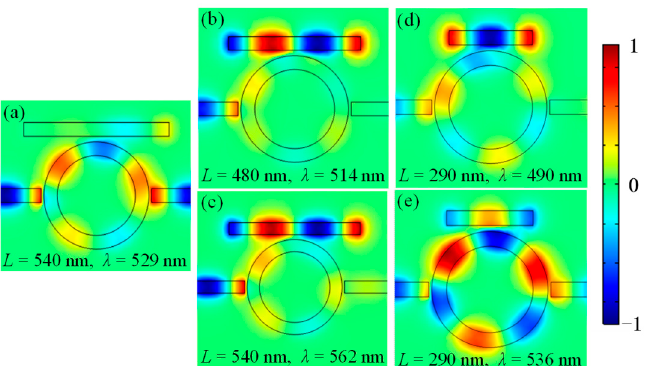
Figure 5. Hz Field distributions of the four points: ‘A’, ‘B’, and ‘C’ (Fano peak) in Figure 3a, ‘D’ and ‘E’, (Fano valley) in Figure 3b. ( a ) L = 540 nm, λ = 529 nm, ( b ) L = 480 nm, λ = 514 nm ( c ) L = 540 nm, λ = 562 nm, ( d ) L = 290 nm, λ = 490 nm, and ( e ) L = 290 nm, λ = 536 nm.